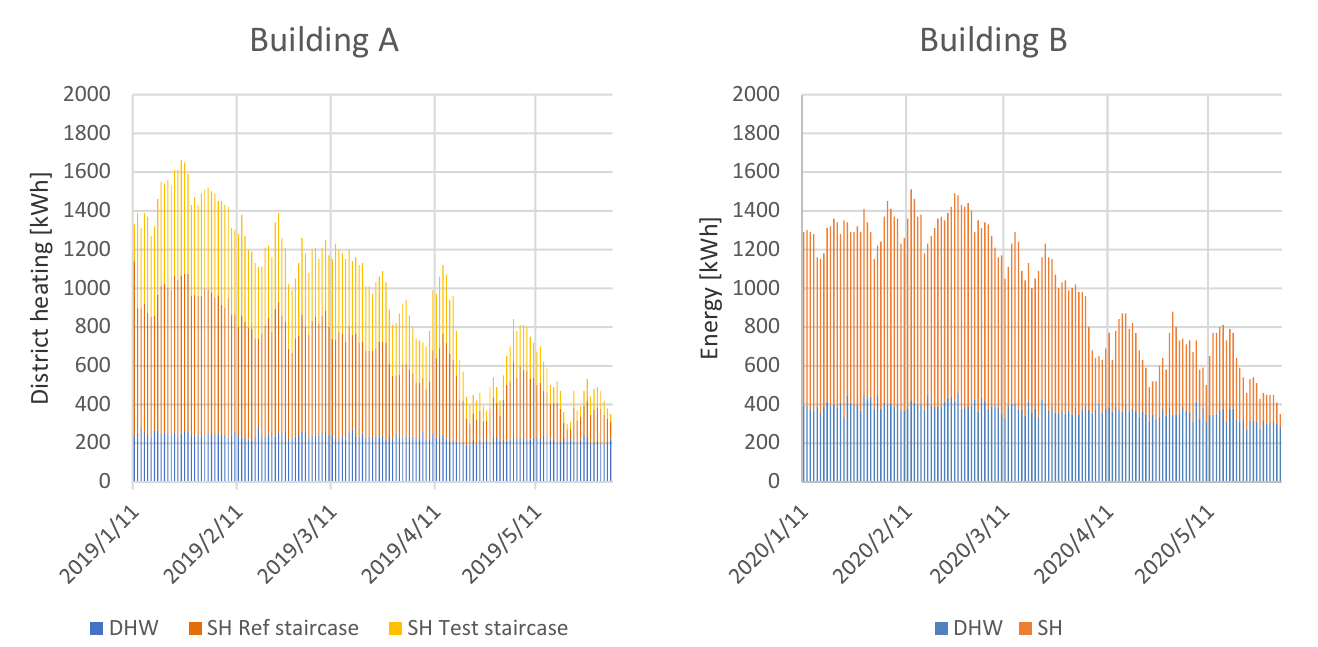
Figure 2. Measurements of energy consumption for domestic hot water and space heating in Building A (in the two staircases) and Building B during the period where the prototypes were tested.